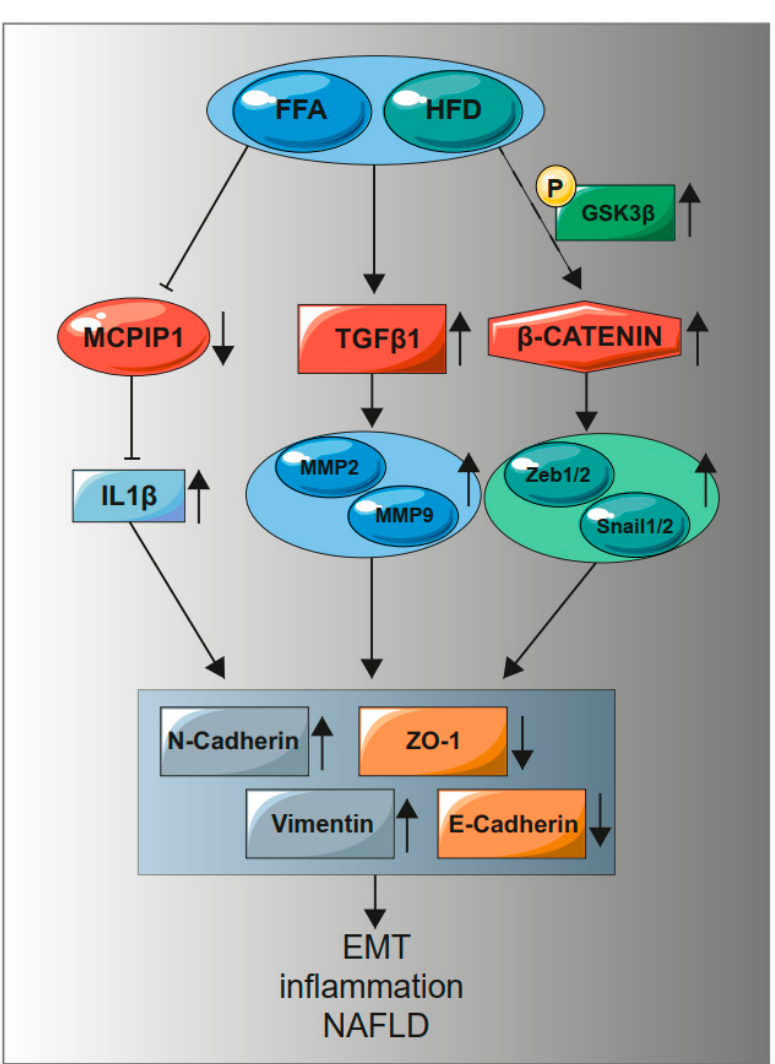
Figure 6. A high-fat diet and treatment with fatty acids increase the level of TGF β 1, β -catenin while reducing the level of MCPIP1. An increase in TGF β 1 causes an increase in MMP9. A decrease in MCPIP1 induces an increase in IL-1 β , which increases mesenchymal markers with a simultaneous decrease in epithelial markers. Phosphorylation of GSK3 β (S9) inactivates the β -catenin degradation complex, leading to activation of the genes dependent on the WNT/ β -catenin pathway. Activation of MMP9, transcription factors Zeb1/2 and Snail1/2, an increase in IL-1 β induce the EMT process, inflammation, and NAFLD.